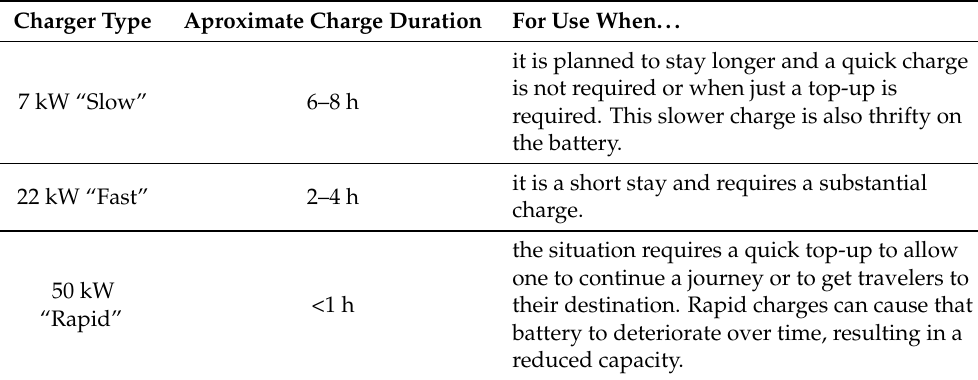
Table 2. Parameters of EV chargers in Glasgow